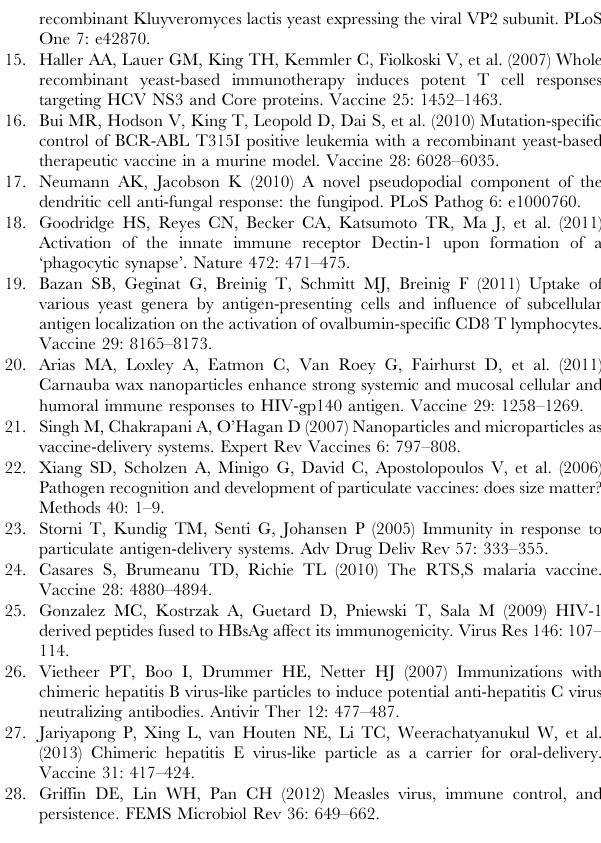
targeting the gene insert demonstrated the absence of genomic DNA (of nucleus origin) in samples analyzed by NanoDrop for total RNA content. Figure S3 Heat-inactivation of P. pastoris GS115, KM71 and SMD1168. The hyphen (-) corresponds to incomplete inactivation and ‘‘n.v.’’ to not-viable yeast. In the figure: test of P. pastoris reproductive activity on YPD plates following heat- inactivation. Each spot corresponds to 1 YU (5 6 10 7 cells), out over 7 days at 30 u C. GS115 heat-treated samples are